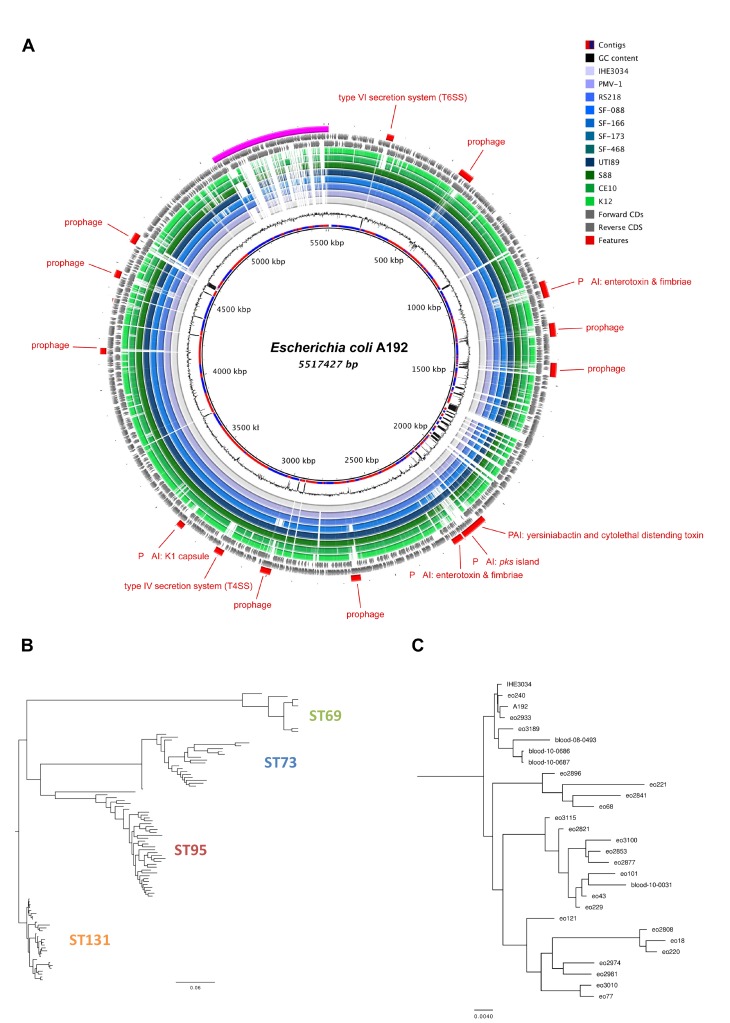
The E. coli A192 genome is comparable to other sequenced E. coli K1 genomes.(A) The E. coli K1 A192 genome was assembled and contiguous consensus sequences ordered according to the IHE3034 genome. From the inside, the circles represent contigs coloured in alternating red/blue, GC content, BLAST analysis of E. coli completed genomes IHE3034, PMV-1, RS218, SF-048, SF-166, SF-173, SF-468, UTI89, S88, CE10 and K12, forward CDS, reverse CDS, virulence factors and unmapped contigs. (B) Phylogenetic relationships of E. coli bloodstream infection isolates; strains were grouped into four sequence types: ST69 (green) ST73, (blue) ST95 (red) and ST131 (yellow). (C) Phylogenetic relationships of E. coli bloodstream infection ST95 isolates. E. coli A192 is closely related to reference genome IHE3034 and contemporary bloodstream infection isolates.